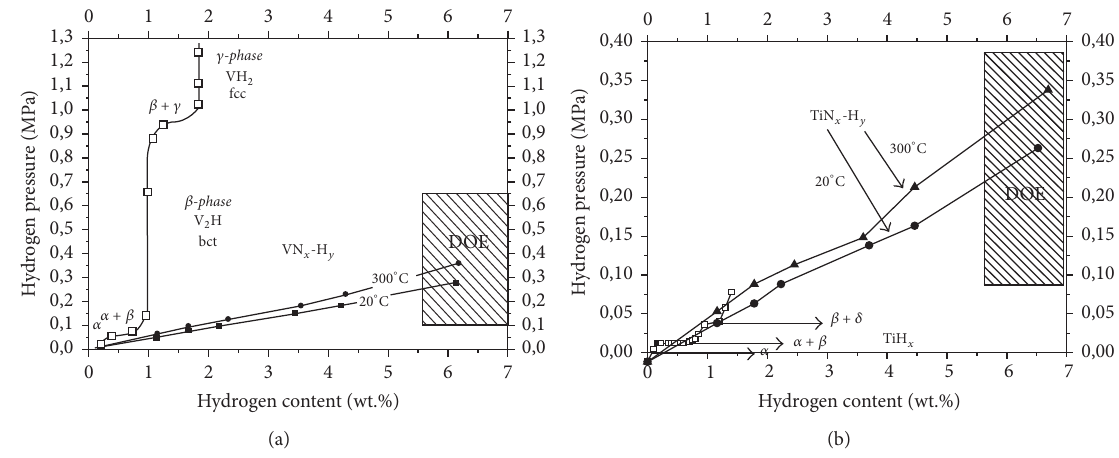
Figure 6: Pressure-concentration dependence for (a) VN 𝑥 -H 𝑦 and (b) TiN 𝑥 -H 𝑦 films. Pressure-concentration diagrams for hydride VH 𝑥 [27] and TiH 𝑥 [28, 29].